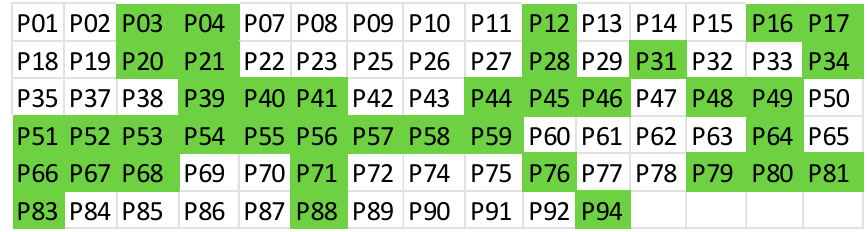
Table 5. Problem size reduction methodology: Ayurá single-objective optimization process.